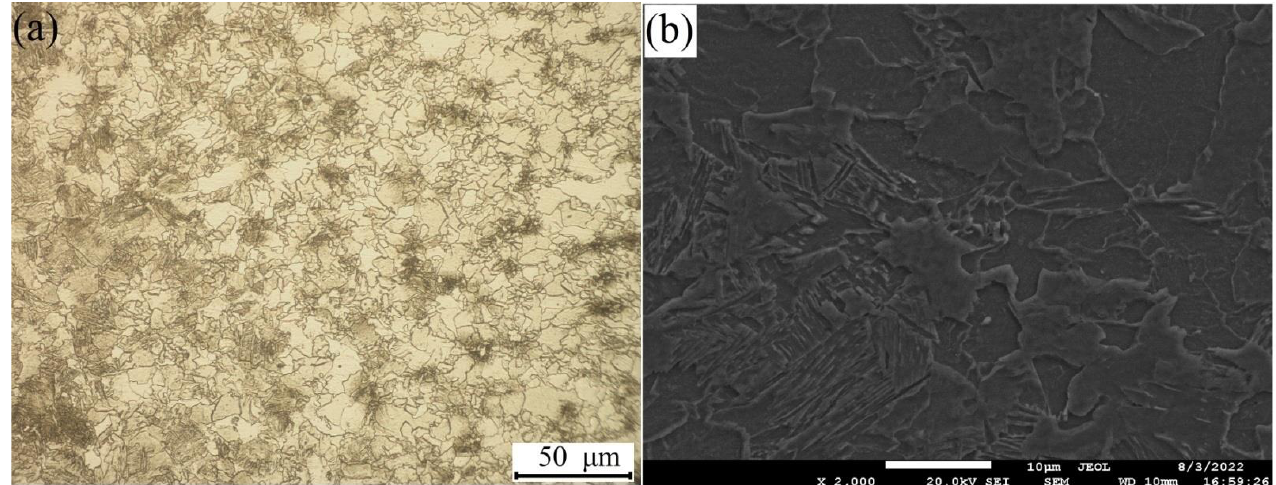
Figure 6. The microstructure of the ICHAZ: ( a ) OM; ( b ) SEM.